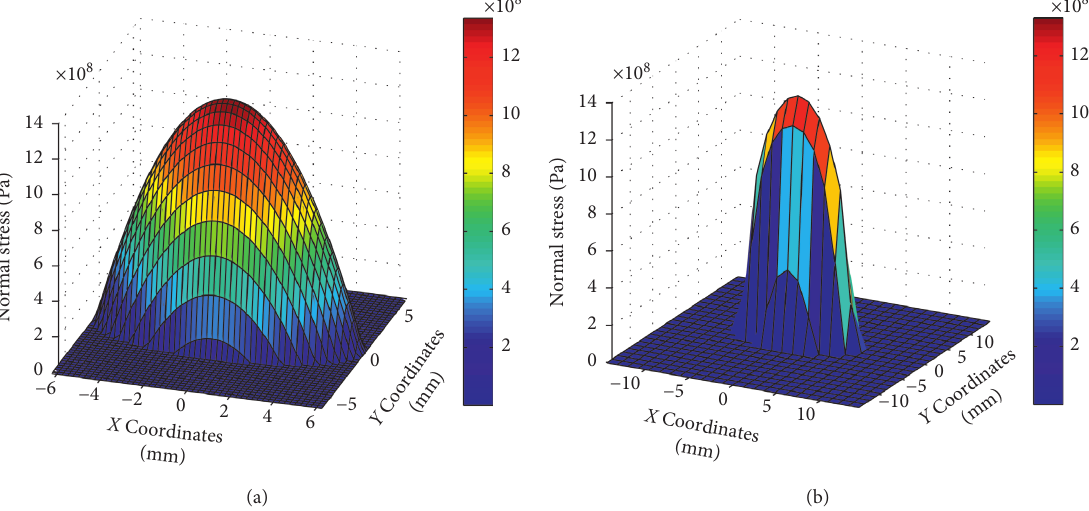
Figure 1: Contact pressure distribution (wheelset transverse displacement is 0mm) based on: (a) Hertz; (b) non-Hertz.